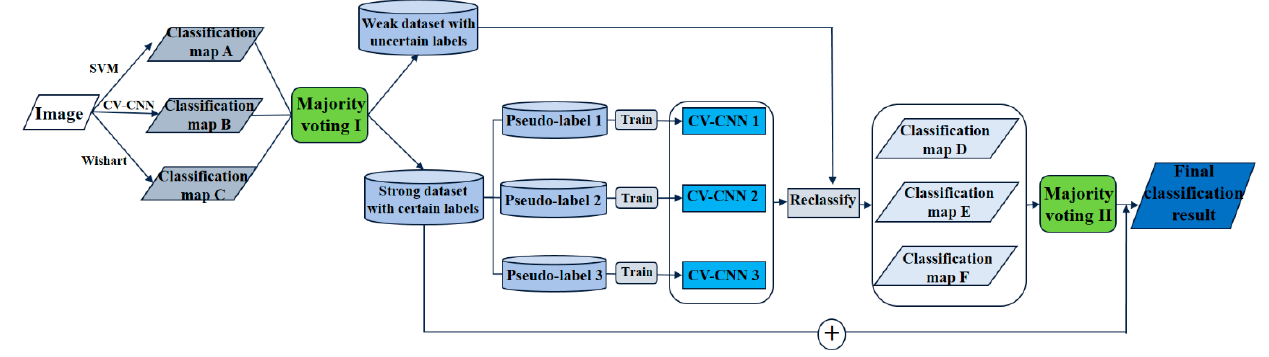
Figure 2. Framework of the proposed model.